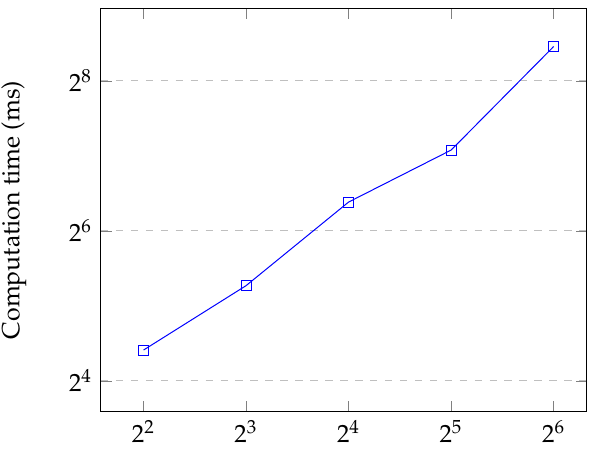
Figure 13. Execution times for N = 256 using different number of impulse responses: 4 to